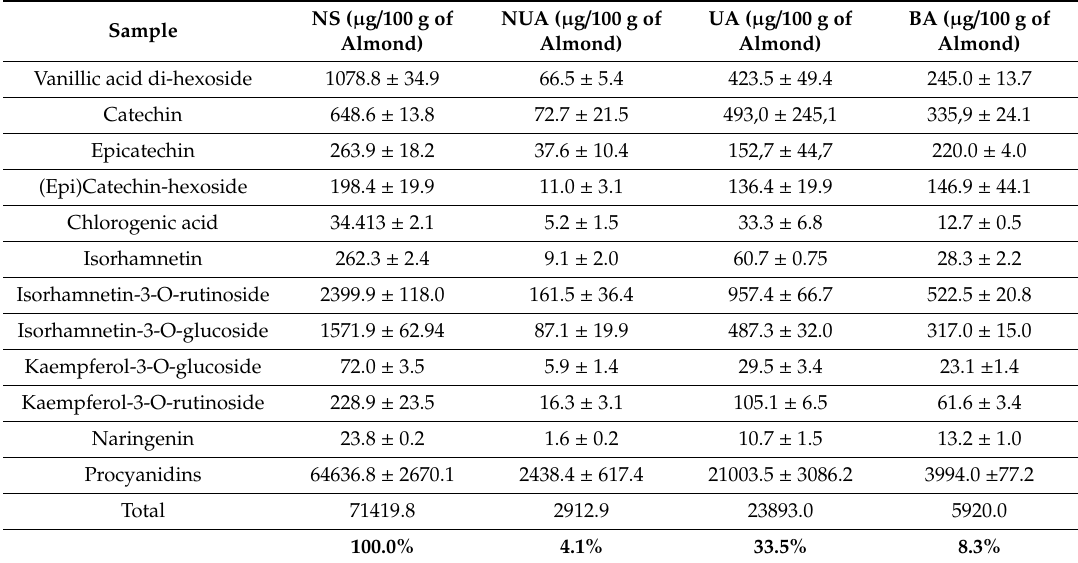
Table 2. Content ( µ g / 100 g of almond) of phenolic compounds in NS, NUA, UA, and BA